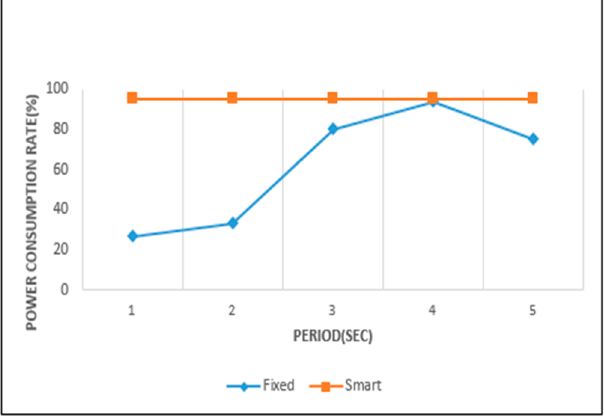
Figure 16. Power consumption of camera sensor.